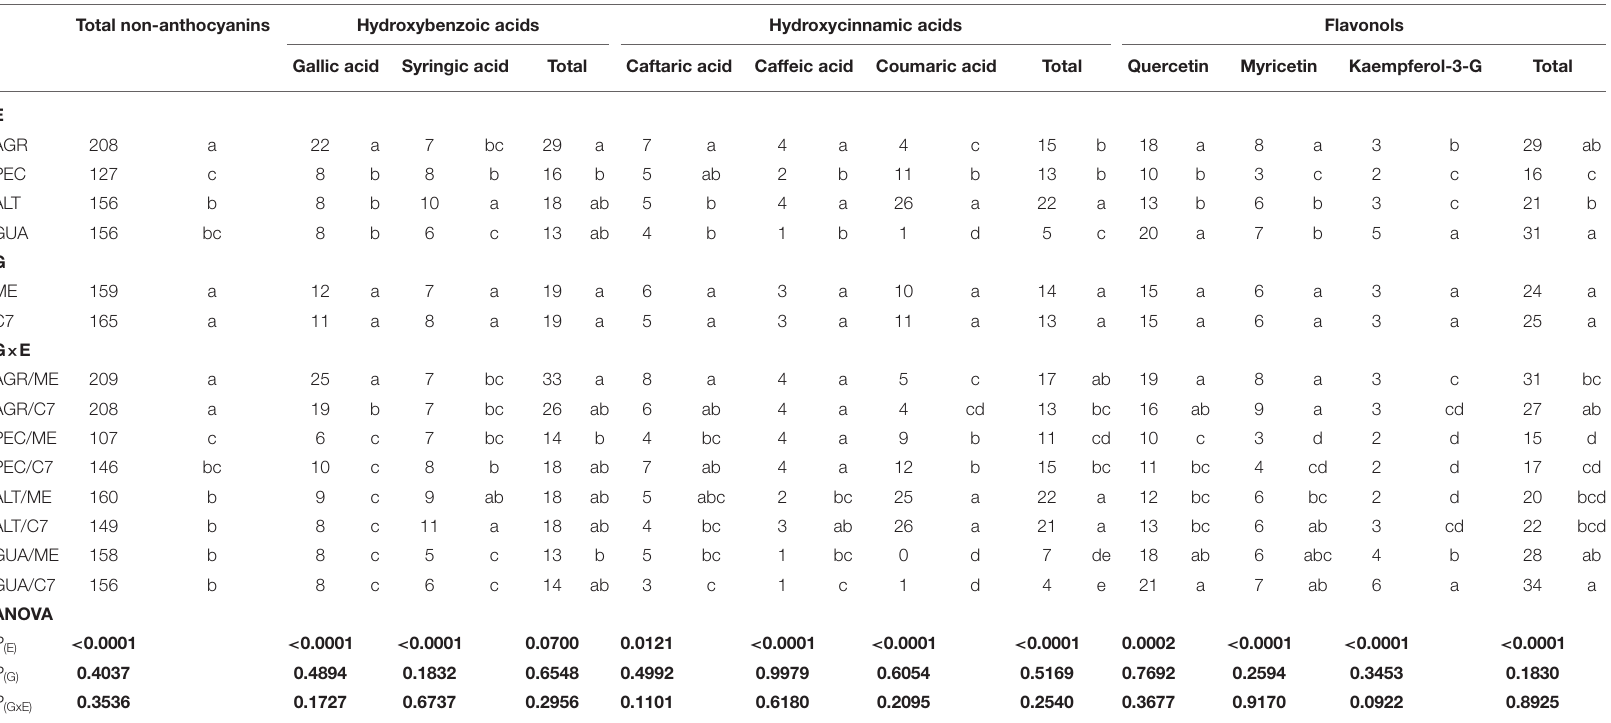
Values are means (mg L − 1 wine) of three replicates (n = 3) and different letters within a column indicate statistically significant differences (Fisher’s LSD test, P < 0.05). P ( E ) , P ( G ) and P ( GxE ) : effects of environment, genotype and their interaction,